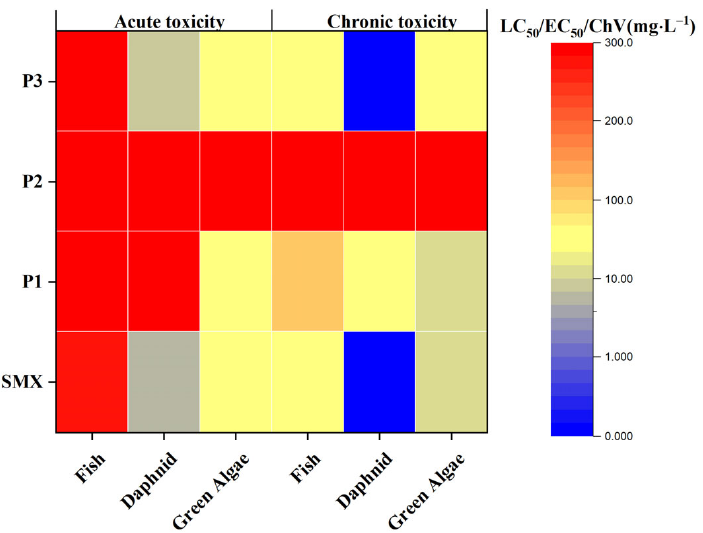
Figure 8. Predicted acute and chronic toxicity of SMX and its degradation intermediates using ECOSAR system.